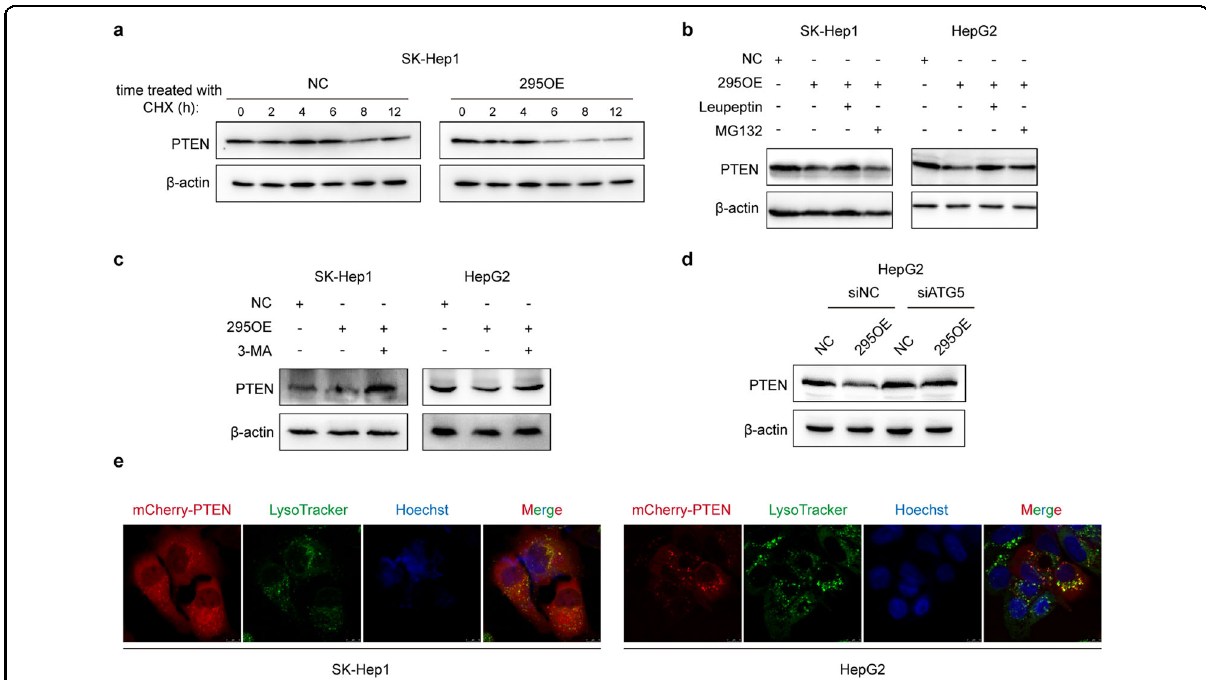
Fig. 4 RP11-295G20.2 downregulates PTEN through the autophagy-lysosome pathway. a RP11-295G20.2 affects PTEN protein stability in HCC cells. SK-Hep1 cells were treated with CHX, and the PTEN protein level was examined by western blotting. b A lysosomal inhibitor but not a proteasome inhibitor reverses the effect of RP11-295G20.2 on decreasing the PTEN level. HCC cells overexpressing RP11-295G20.2 or control vector were treated with either MG132 or leupeptin. The PTEN protein level was examined through western blotting. c , d RP11-295G20.2 regulates PTEN through the autophagy pathway. HCC cells overexpressing RP11-295G20.2 were treated with either 3-MA ( c ) or siATG5 ( d ) prior to assessment of the PTEN protein level. e PTEN is localized in the lysosome. SK-Hep1 or HepG2 cells were transfected with the mCherry-PTEN vector and stained with LysoTracker. PTEN puncta are indicated with red dots, and the lysosomes are indicated with green